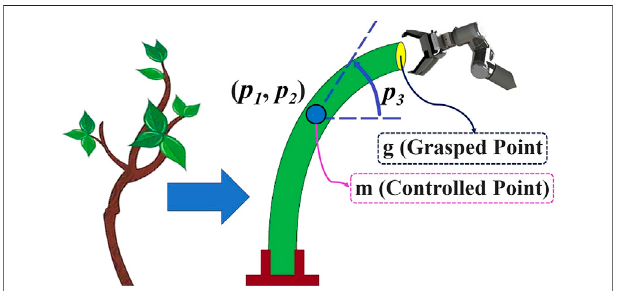
FIGURE 1 | Considered object in the current